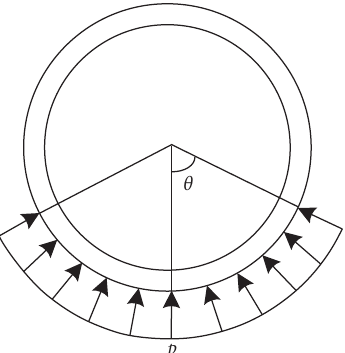
Figure 6: Grouting pressure distribution on the